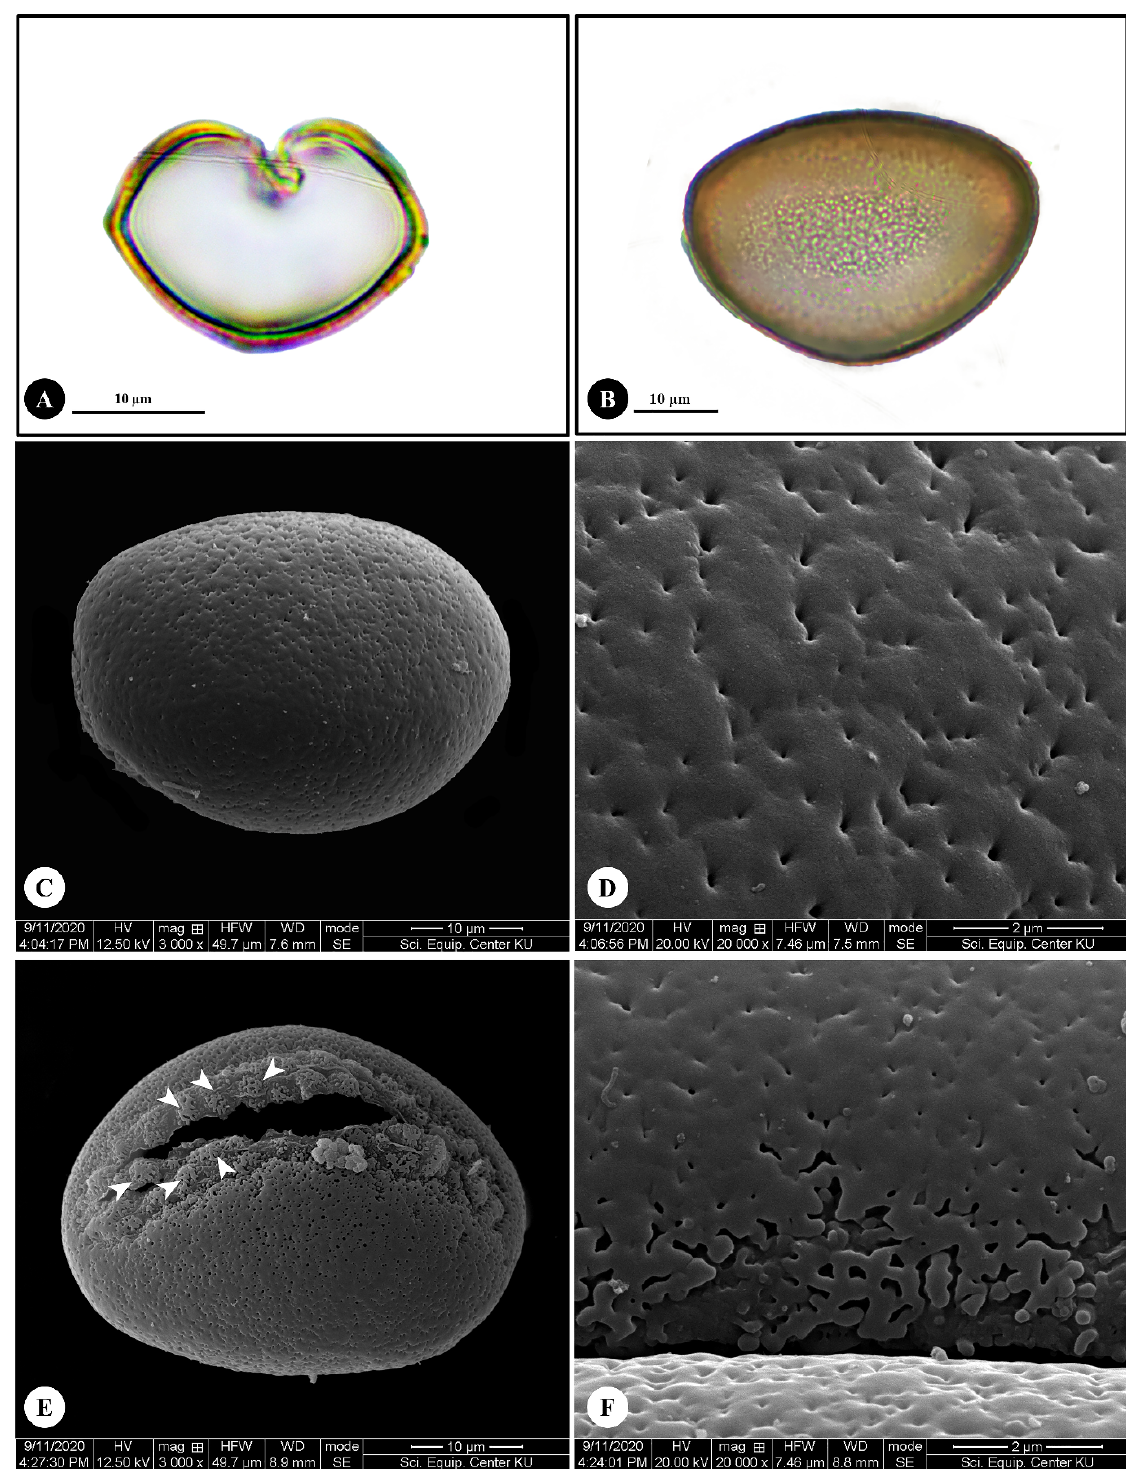
Figure 4. Pollen morphology of Disporopsis longifolia . ( A , B ) Light microscope images; ( A ) polar view; ( B ) equatorial view. ( C – F ) Scanning electron microscope images; ( C ) equatorial view; ( D ) perforate ornamentation; ( E ) monosulcate and areolate ornamentation (arrowheads); ( F ) areolate ornamentation (top